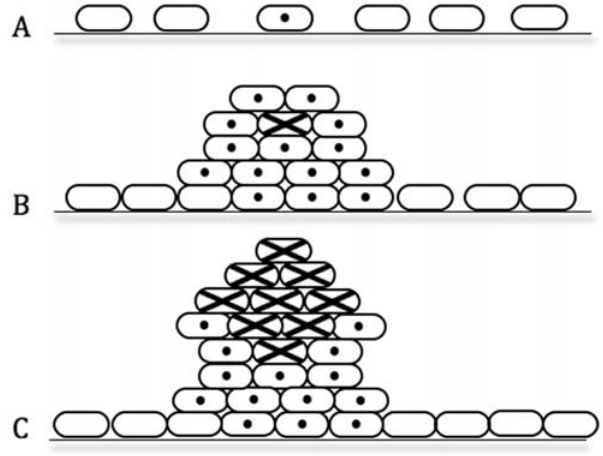
Figure 4. Microevolutionary model for microbial biofilm growth. (A) A bacterial cell attached to a substratum acquires a primary mutation ( $ ) that provides a growth advantage on the surface; (B) mutation selection and clonal expansion occurs; some cells acquire beneficial secondary mutations ( (cid:1) ), for example due to exogenous DNA damaging stresses localized to microcolonies; (C) subsequent waves of clonal expansion contribute to microcolony growth and proliferation.